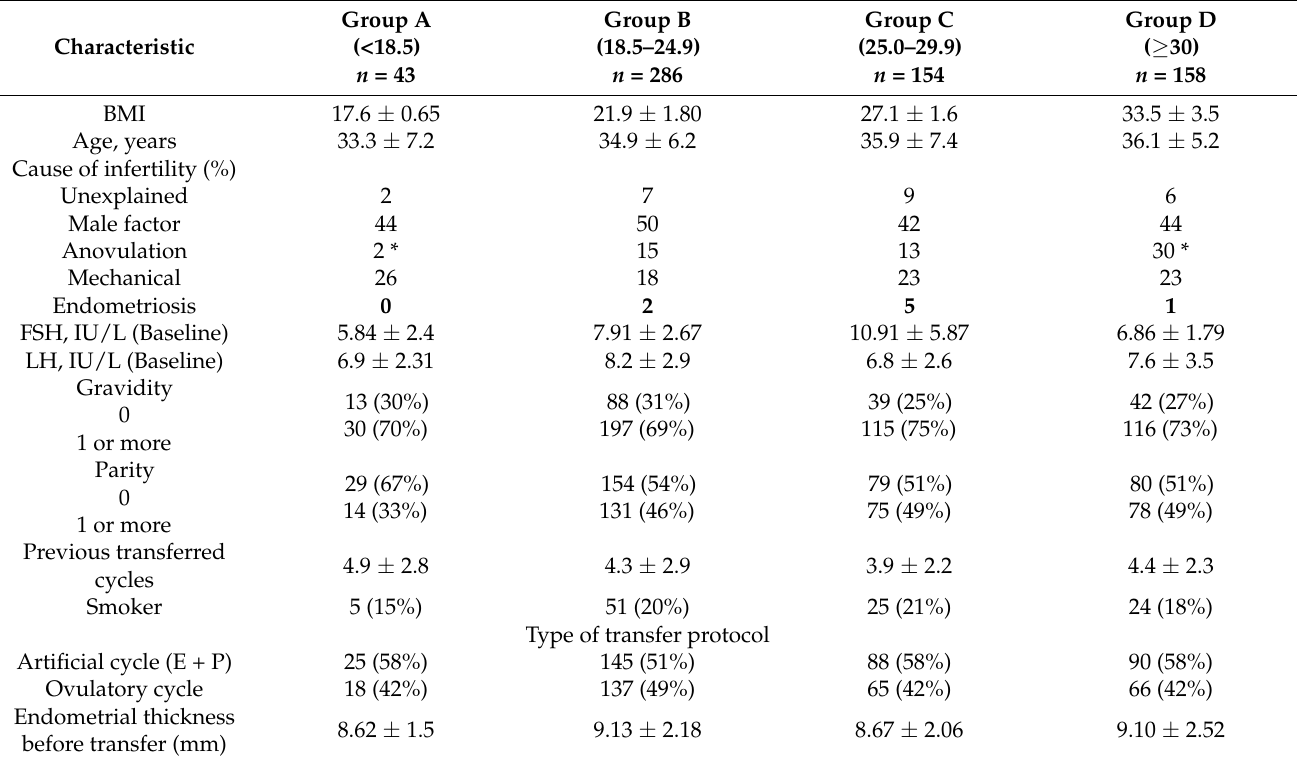
Table 1. Patients’ characteristics according to BMI group.